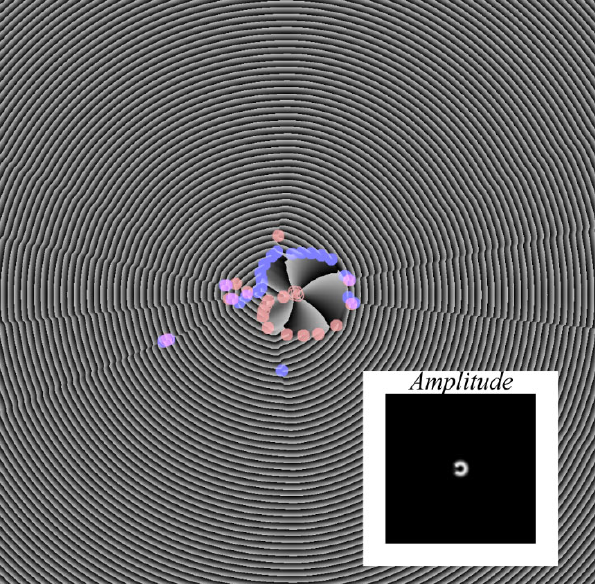
Figure 4. Amplitude (inset) and phase of the light field of Equation (14) having passed the sector aperture of Equation (15) with the angle α = 150° at a distance of z = λ behind the aperture. Positive dislocations are purple shaded circles and negative ones are within cyan shaded circles. Both amplitude and phase field sizes are 48 × 48 μ m.